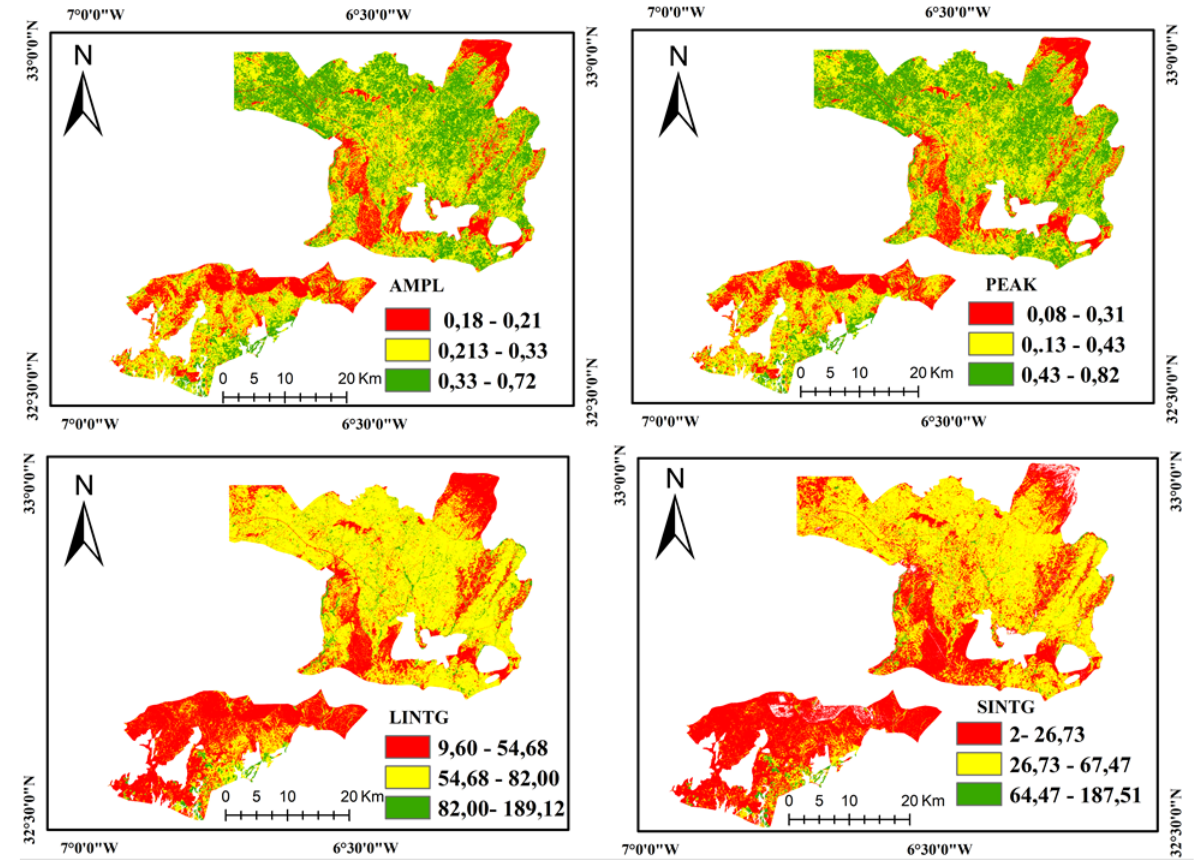
Figure 5. Phenological Factors.